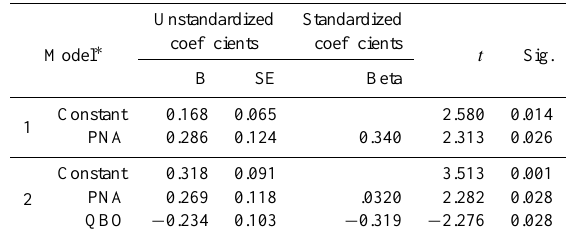
Table 6. Coefficients of univariate and multivariate regression models.